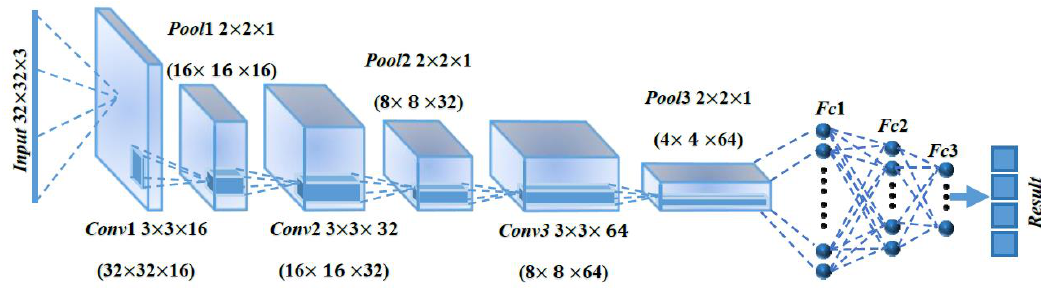
Figure 8. Architecture of the CNN used in this paper.